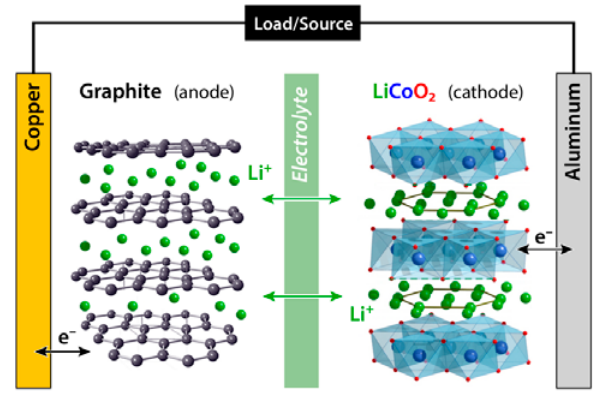
Figure 5. Scheme of a lithium ion battery, where Co 4+ /Co 3+ half reaction occurs at the cathode and redox-promoted intercalation of lithium in graphite takes place at the anode.